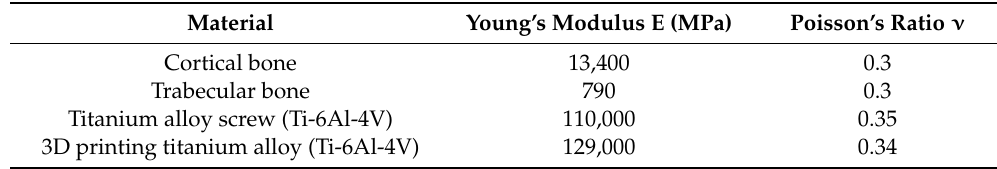
Table 1. Material properties used in the finite element (FE) model [17,18].